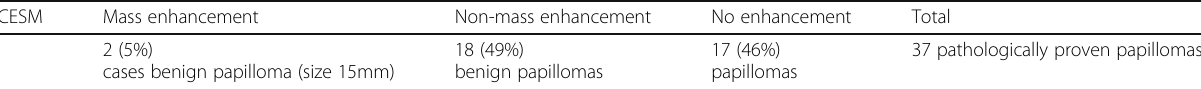
Table 4 Correlation between mass/non-mass enhancement of papilloma cases on CESM CESM Mass